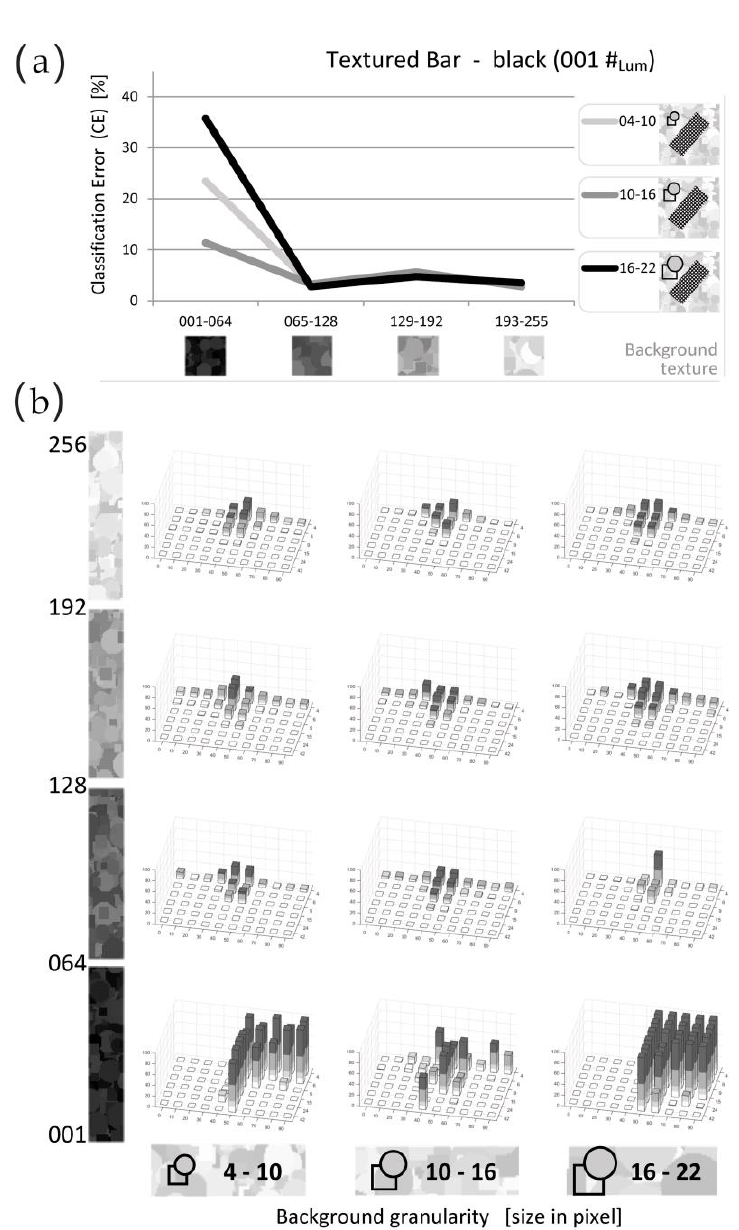
Figure 9. Textured Black Bars on textured Background—black bar. In the third group of tests, we assessed HMAX when working on images composed by textured bar on textured background. The background texture was composed by a random distribution of squares and circles; 12 experimental conditions are originated by three possible texture sizes (i.e., Granularity) and four possible texture Luminance values. The adopted bar texture was the “Large” black texture, 60% density, already used in previous tests. ( a ) CE mean value resulting from each test; the three di ff erent lines refer each one to a di ff erent background Granularity (04–10, 10–16, or 16–22 pixels in diameter). Our X-axis presents the four consecutive intervals of background Luminance. ( b ) Detailed results for each one of the 12 Texture conditions (4 luminance values—in row, and 3 granularities—in column). In each histogram, the X and Y axes report respectively the 10 orientations and the 6 sizes characterizing each item, as previously presented in Figure 3. Diagrams show that HMAX guarantees accurate and precise results in all conditions but in the darkest, where results diverge due to the low luminance contrast between bar and background.